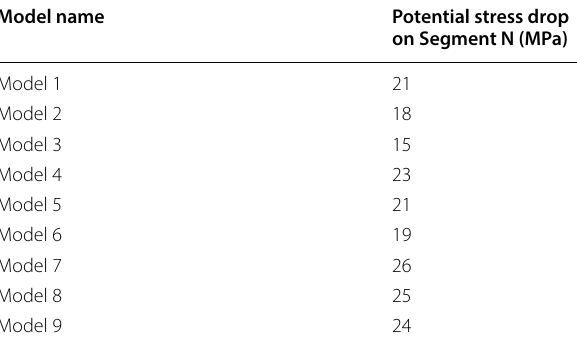
Table 1 Potential stress drop on Segment N in each stress